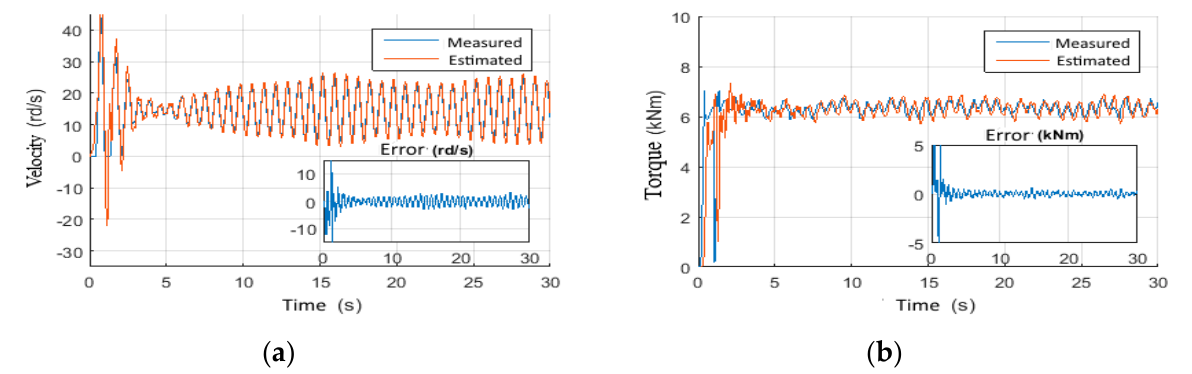
Figure 17. Measured and estimated variables by the designed observer for Scenario-4: ( a ) Rotational velocities, ( b ) Stick-slip severity.